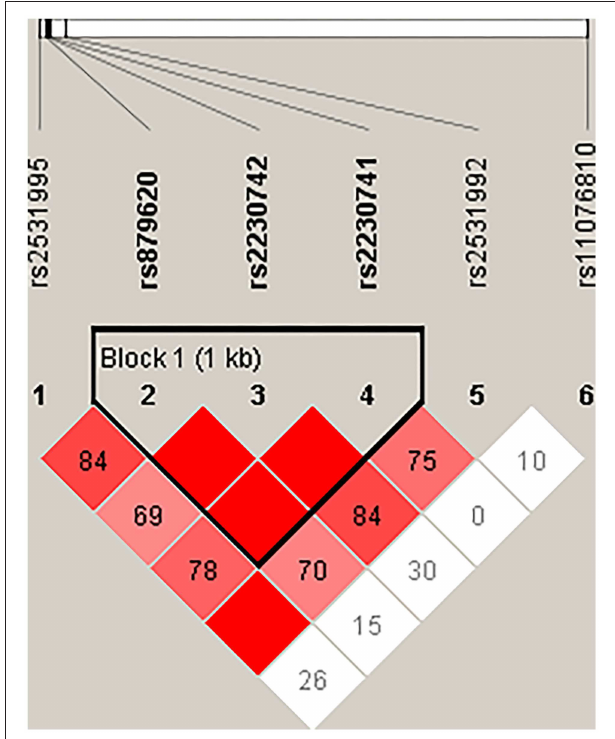
FIGURE 1 | Haplotype block map for the SNPs of ADCY9. Block includes rs879620, rs2230742, and rs2230741. The LD between two SNPs is standardized D ′ .